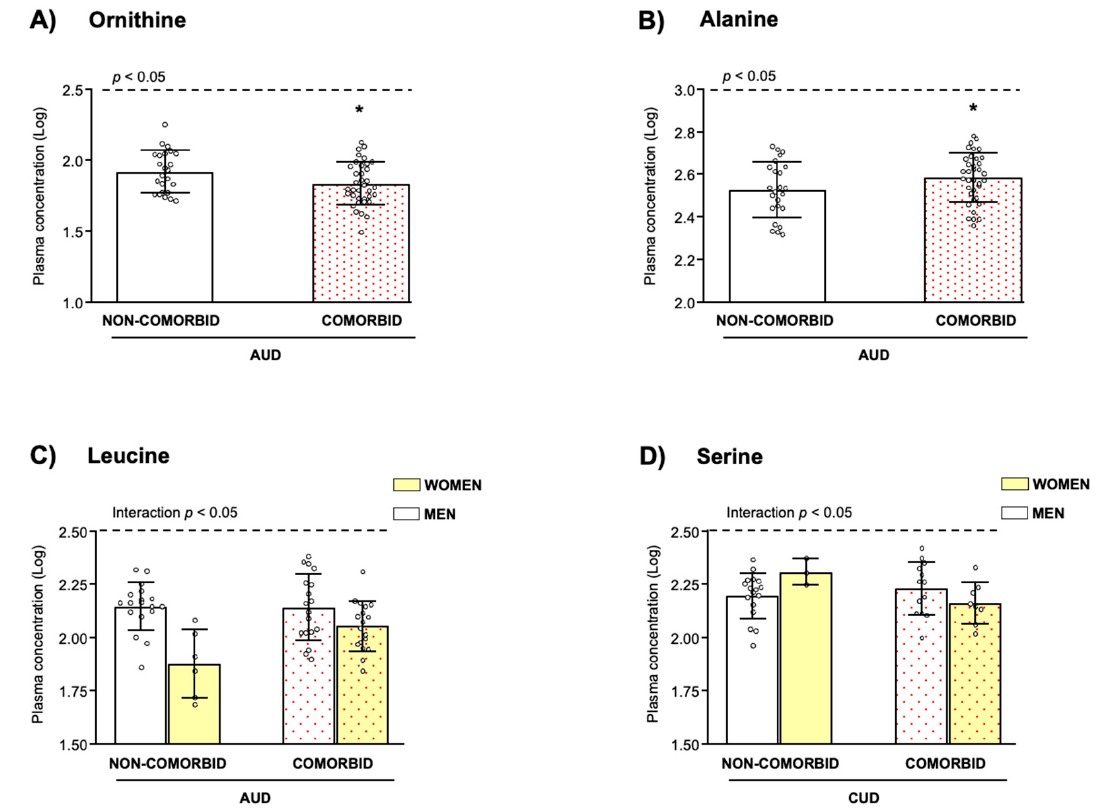
Figure 4. Plasma amino acid concentrations in relation to sex and psychiatric comorbidity in the SUD groups. ( A ) L-Ornithine in the AUD group; ( B ) L-Alanine in the AUD group; ( C ) L-Leucine in the AUD group; and ( D ) L-Serine in the CUD group. Dots are individual values. Bars are estimated marginal means and 95% CI of log 10 -transformed amino acid concentrations. Data were analyzed by two-way ANCOVA with “sex” and “psychiatric comorbidity” as factors while controlling for age and BMI. Significant main effects ( A , B ) or interactions ( C , D ) were represented. (*) p < 0.05 denotes significant differences compared with patients without comorbid psychiatric disorders.